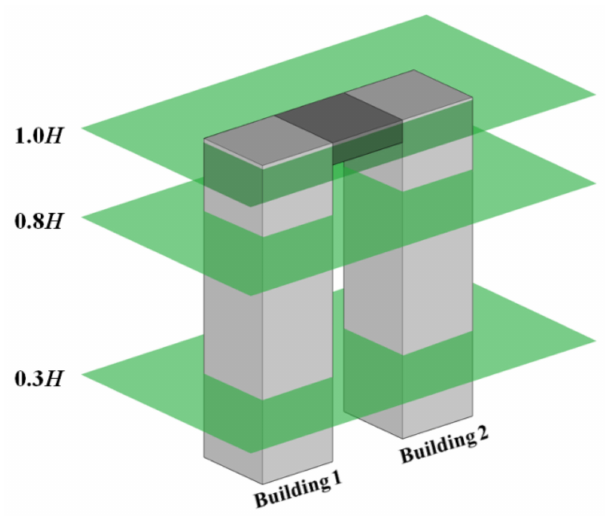
Figure 3. Wind-flow measurement